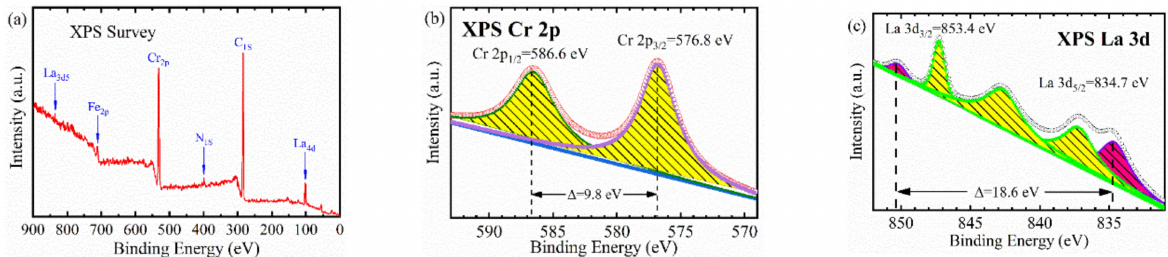
Figure 9. XPS spectra modified layer of 3Cr13 steel after RE plasma nitriding for 12 h ( a ) Survey spectra ( b ) Cr 2p spectra ( c ) La3d spectra.